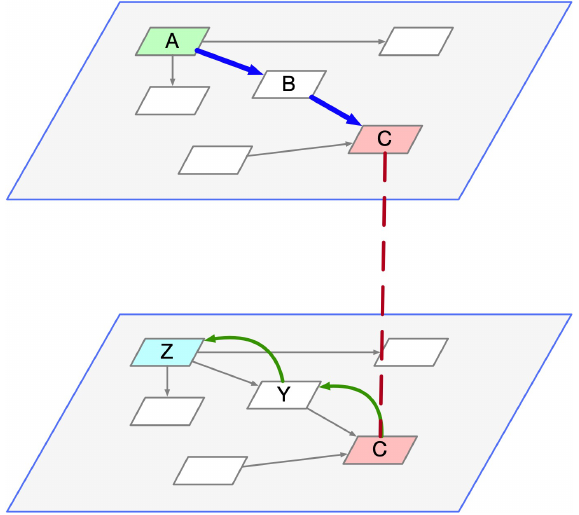
Figure 3. Schematic representation of relative sentence walks. Entities A and Z are two different main entities, along with their connecting entities in gray. Both main entities share an intrinsic connection to entity C, which is not expressed in the CIDOC-CRM logic (represented here by a red dashed line). The relative sentence walk can then reverse walk to connect entities A and Z, through C, shown here in green